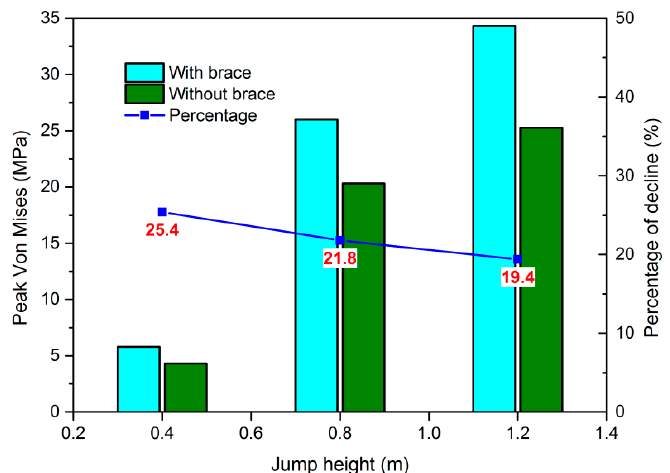
Figure 3. Maximum von Mises stress of the inferior articular surface of the tibia with and the brace, and the percentage decline in peak value at the three different